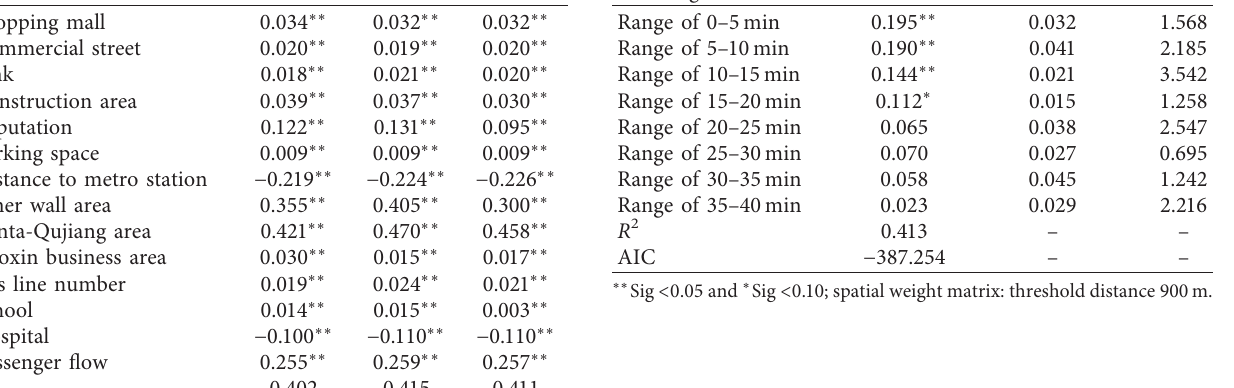
Table 7: Comparison of the HPM, SAR, and SEM models.